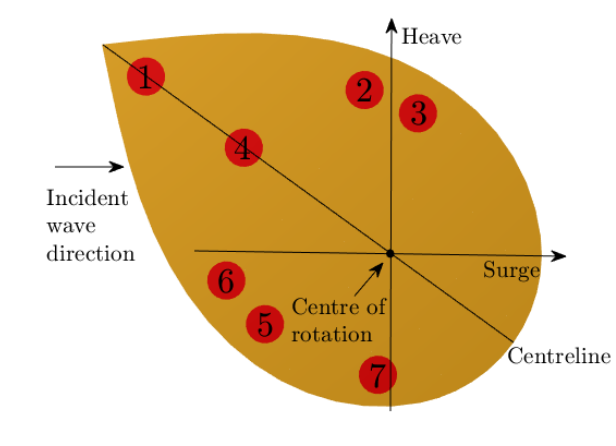
Fig. 1. Cross-section of a single member of the full spine of ducks, with the seven ballast tubes displayed. Sway is defined into the page, with the axes centred halfway along the spine